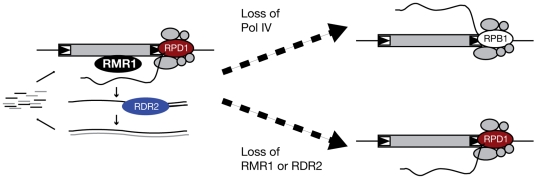
A model for RMR1, RDR2, and RPD1 action at LTR retrotransposons.Pol IV generates a low-level of precursor RNA that is amplified by RDR2 into double-stranded RNA that is then processed into small RNAs. The ability of Pol IV to generate a RDR2 template is facilitated by the action of RMR1. Upon loss of RPD1 the Pol IV complex fails to assemble on LTR retrotransposon templates and the elements are instead transcribed by the Pol II complex which generates polyadenylated transcripts. In the case of RMR1 or RDR2 deficiencies, the amplification of aberrant, non-coding transcripts by RDR2 is lost, but Pol IV still acts at LTR templates and prevents Pol II recruitment.